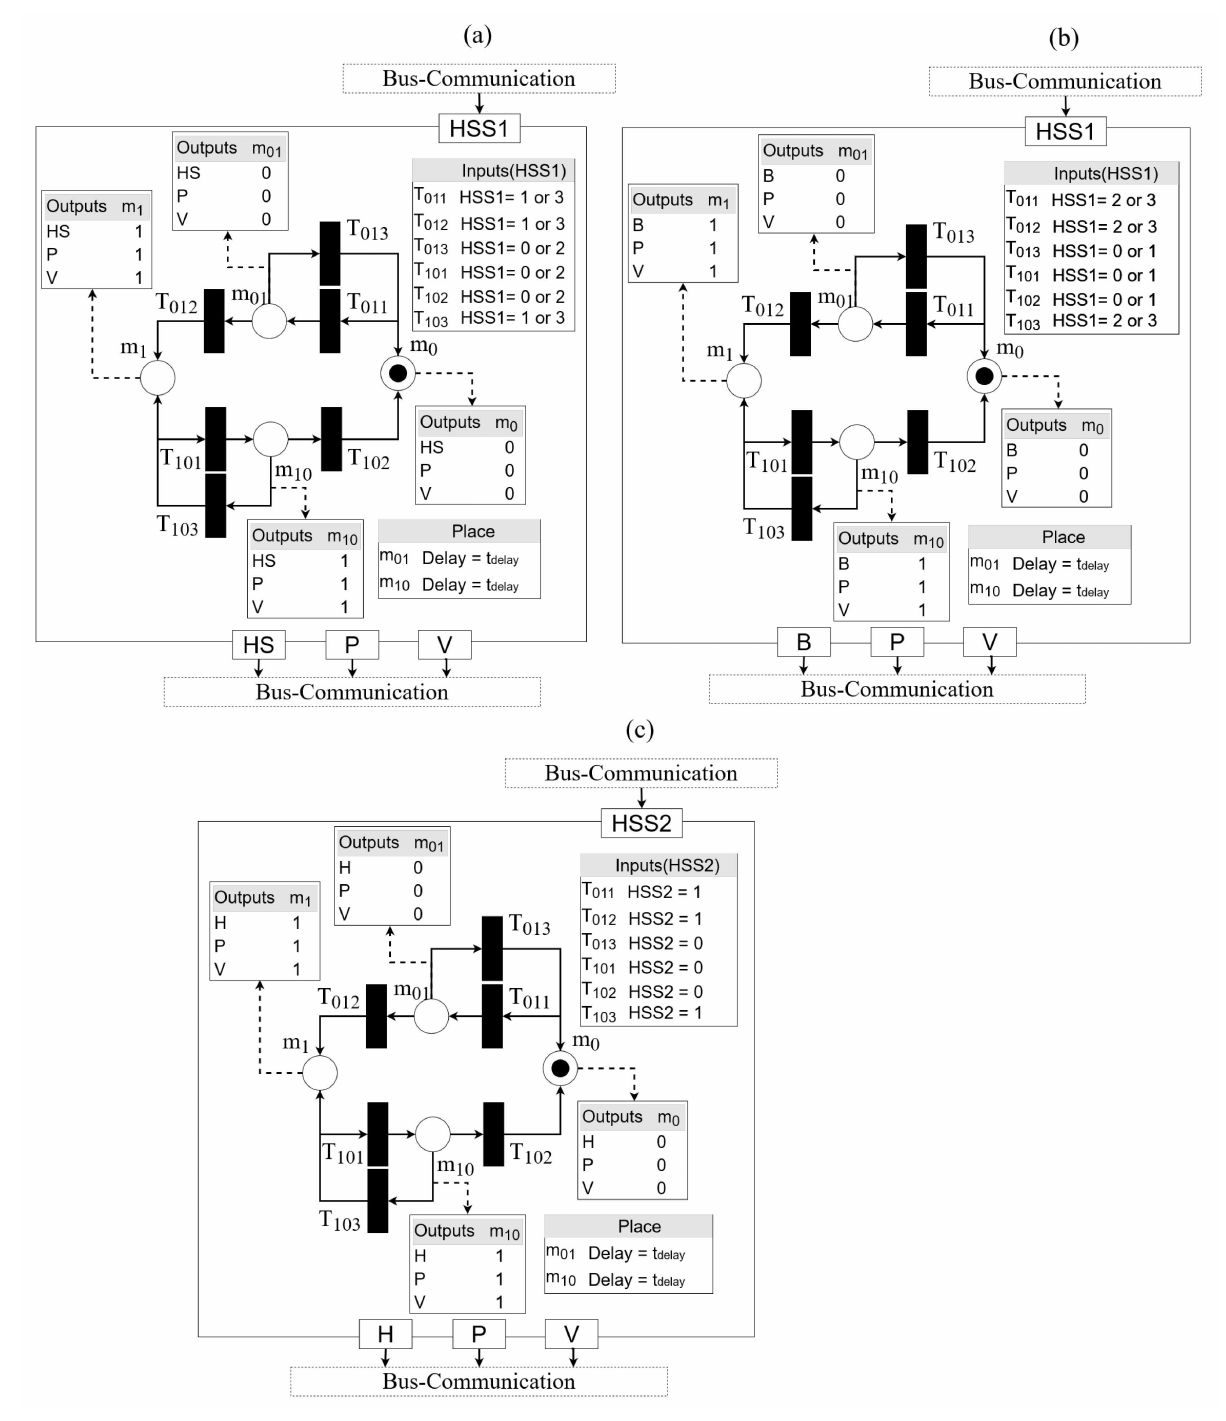
Figure 10. The control function of the heat supply system at the component level based on SIPNs. ( a ): the control model of the heat storage; ( b ): the control model of the boiler; ( c ): the control model of the heat pump. HSN: heat supply network; HSS1: heat supply subsystem 1; HSS2: heat supply subsystem 2; S: sensor data, HS: heat storage; B: boiler; HP: heat pump; P: pump; V: